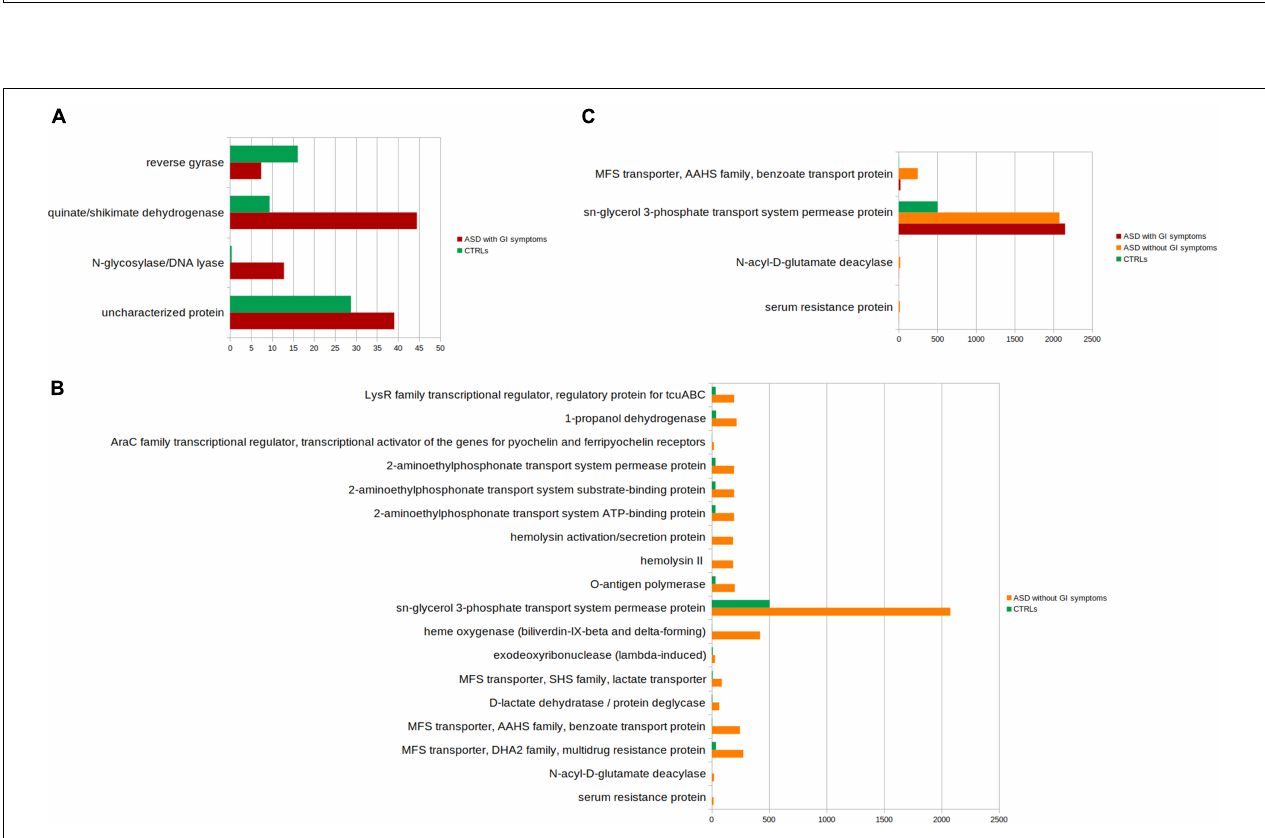
FIGURE 7 | Kyoto Encyclopedia of Genes and Genomes (KEGG) biomarkers inferred from the whole set of OTUs of the patients with ASD and the CTLRs subjects. A linear discriminant effect size (LEfSe) analysis was performed [ α = 0.05, a logarithmic discriminant analysis (LDA)] score threshold = 2.0). ASD- and CTRLs-related KEGGs entries are represented in red and green bars, respectively.